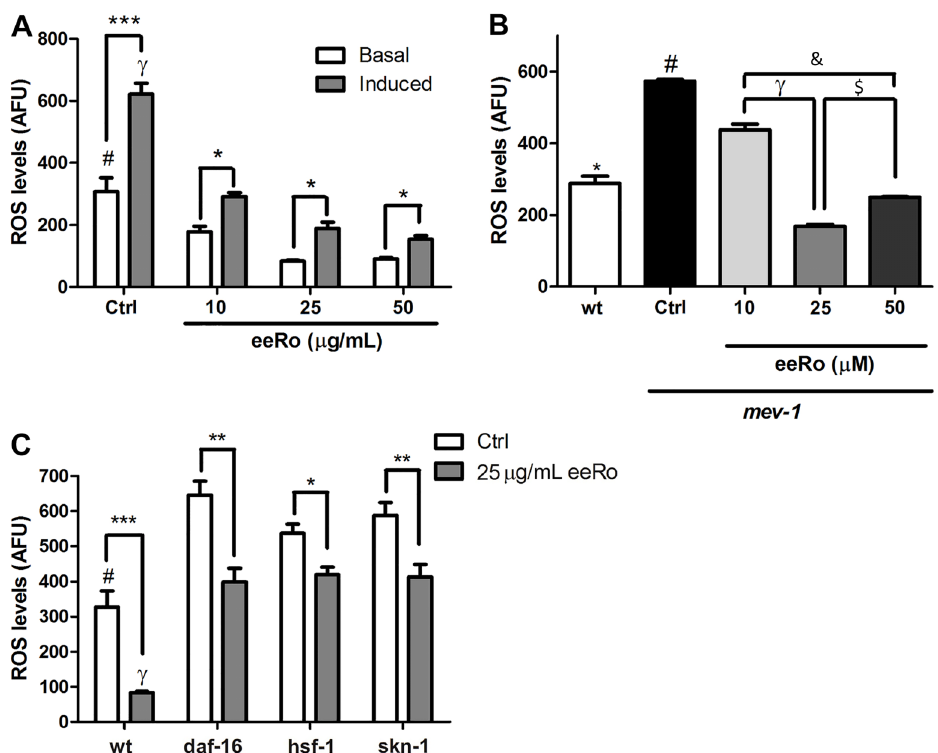
Figure 3. Effect of ethanolic extract of Rosmarinus of fi cinalis L. (eeRo) on reactive oxygen species (ROS) production. Data are reported in arbitrary fl uorescence units (AFU) from 3 independent assays (n=3). A , Levels of basal and H 2 O 2 -induced (25 mM/1 h) ROS production in wild-type (N2) worms. *P o 0.001 compared to eeRo-treated basal groups; # P o 0.001 compared to eeRo-treated induced groups; g P o 0.01 Ctrl basal compared to Ctrl induced groups. B , Levels of ROS production in wild-type (N2) and mev-1 (TK22) worms. *P o 0.001, compared to all other groups; # P o 0.001, compared to all other groups; g P o 0.001, 10 m M compared to the 25 m M eeRo treated group; $ P o 0.001, 25 m M compared to the 50 m M eeRo treated group; & P o 0.001, 10 m M compared to the 50 m M eeRo treated group (one-way ANOVA). C , ROS levels in daf-16, hsf-1 and skn-1 mutants treated or not with the extract. *P o 0.05, **P o 0.01, ***P o 0.001, treated compared to untreated group; # P o 0.01, compared to the other Ctrl groups; g P o 0.01, compared to the other treated groups (two-way ANOVA).